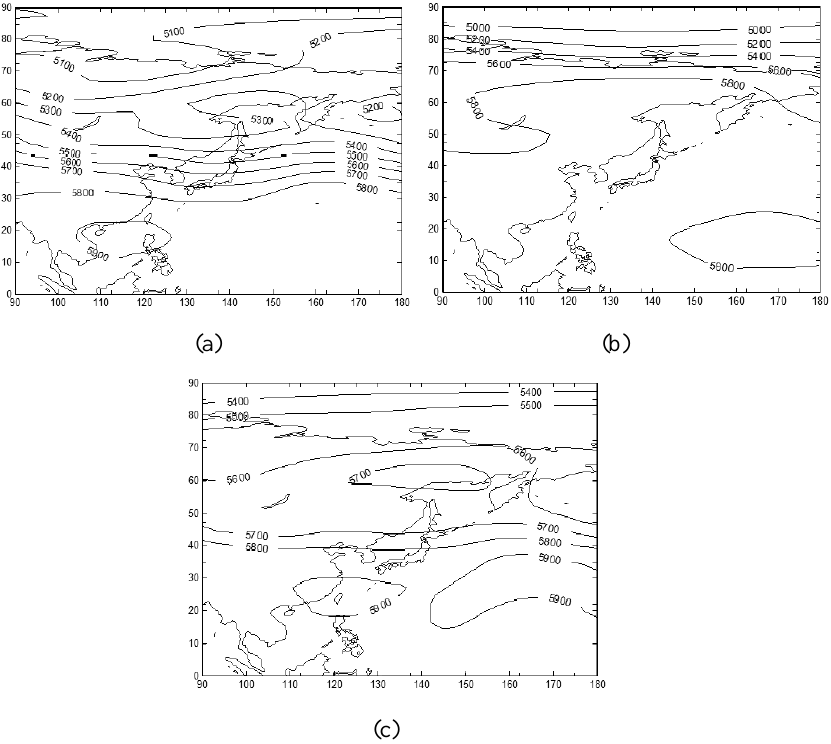
Fig. 7. The summer SH potential fields of (a) the high equilibrium and (b) the low equilibrium in 2006 reconstructed before combination